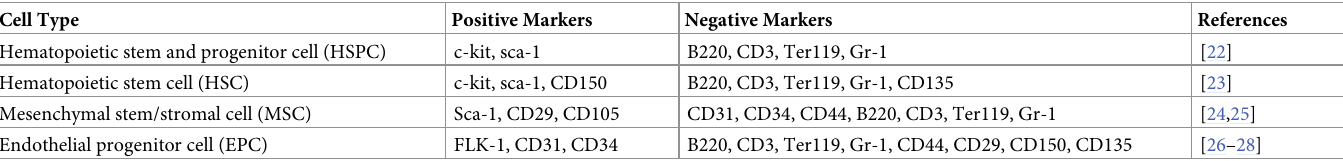
Table 1. Flow cytometry